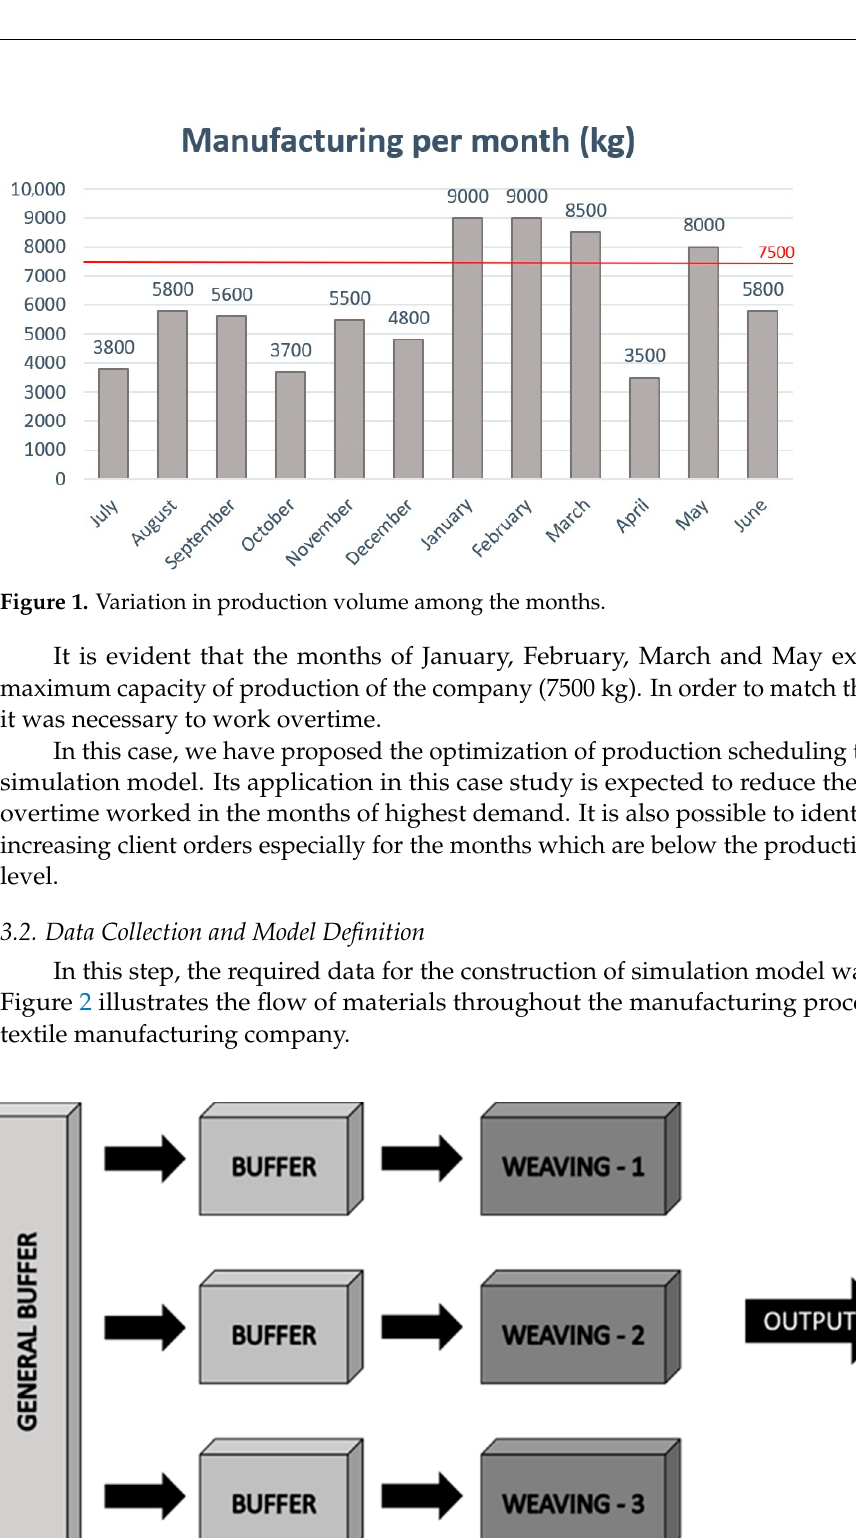
Figure 2. Flow of materials through the manufacturing processes.